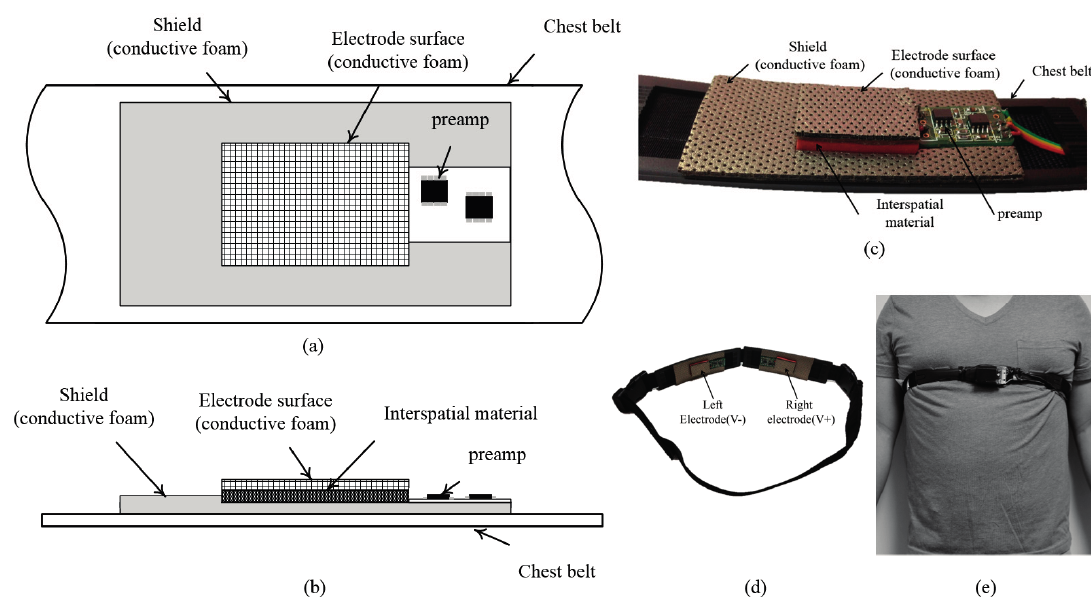
Figure 1. Configuration of the flexible electrode: ( a ) Top view; ( b ) side view; ( c ) photograph of actual electrode; ( d ) overall design; ( e ) person with the system around the